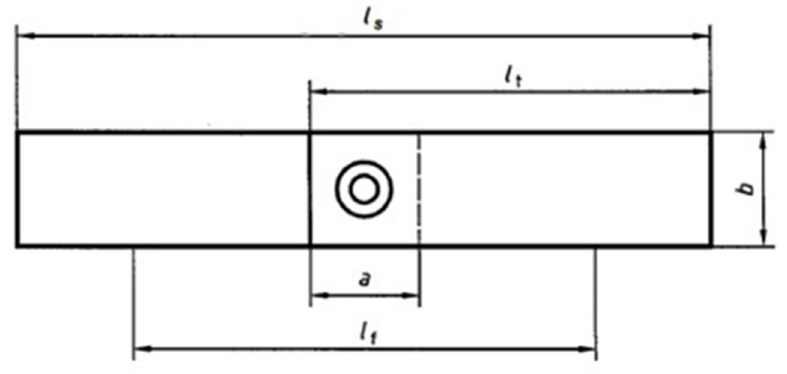
Figure 8. Standard specimen for the shear strength [49].